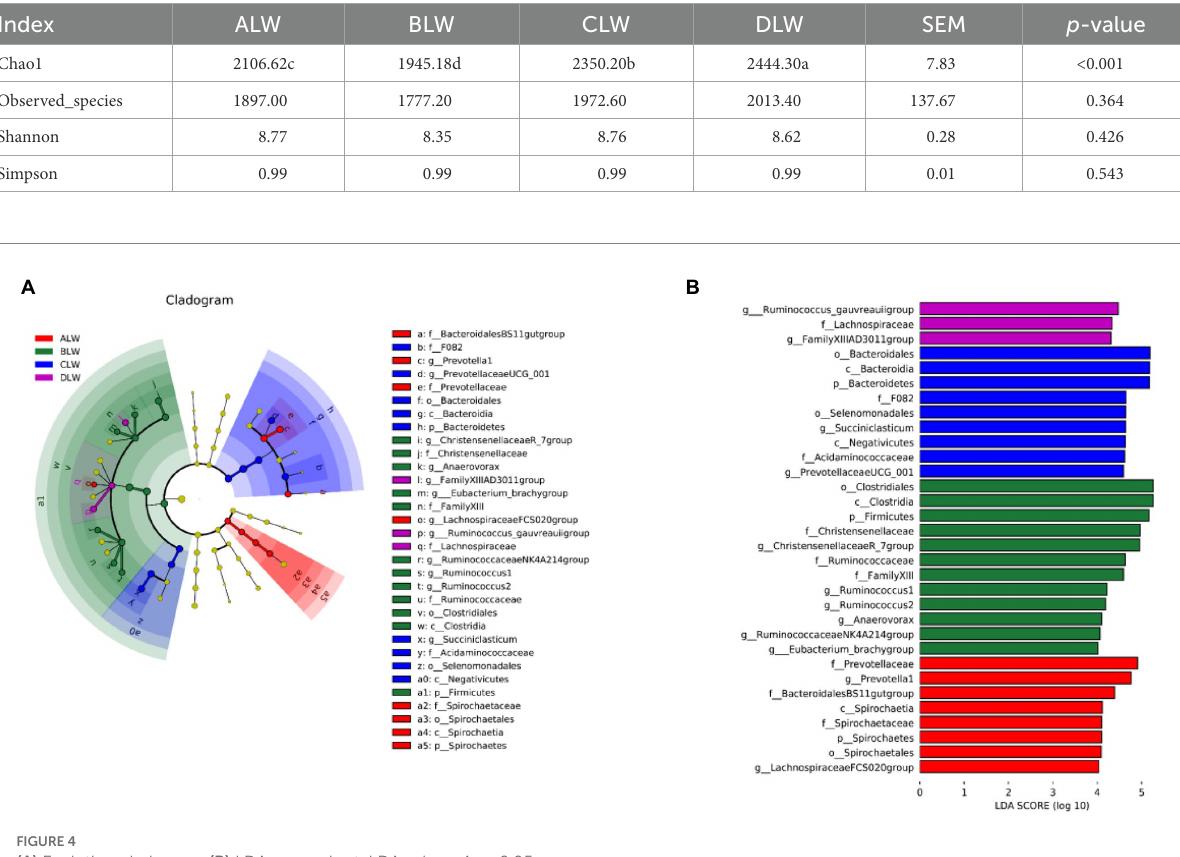
TABLE 3 The effect of EOZB on jejunum alpha diversity